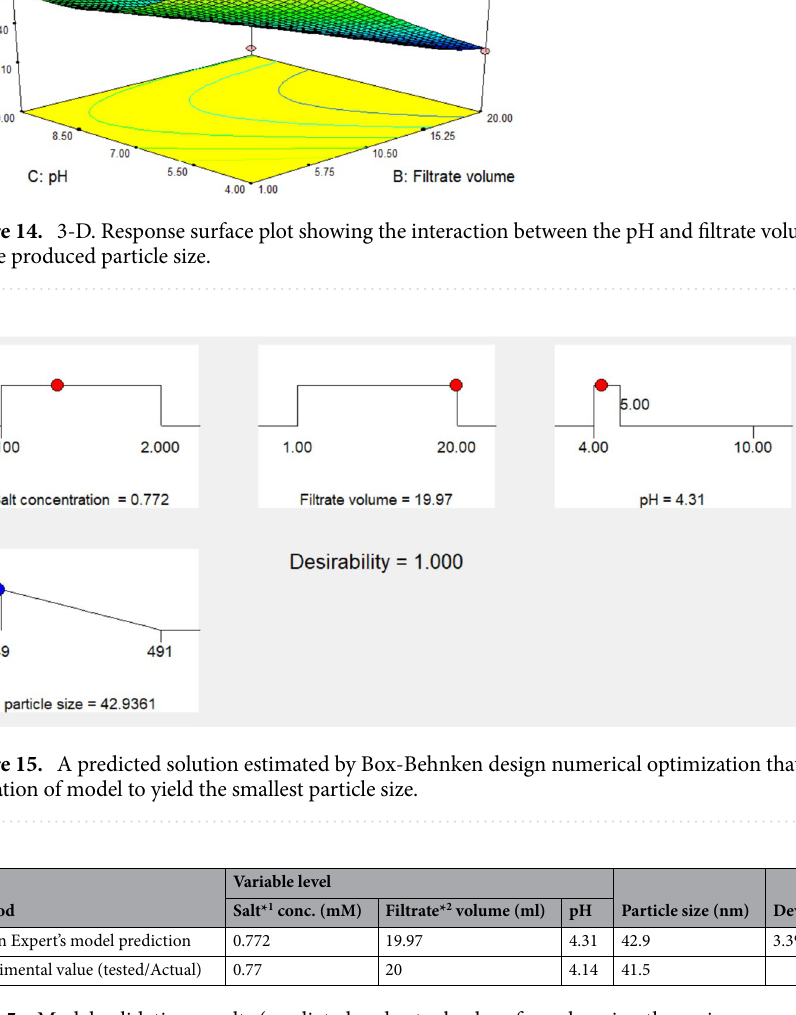
Table 5. Model validation results (predicted and actual values for enhancing the main response).